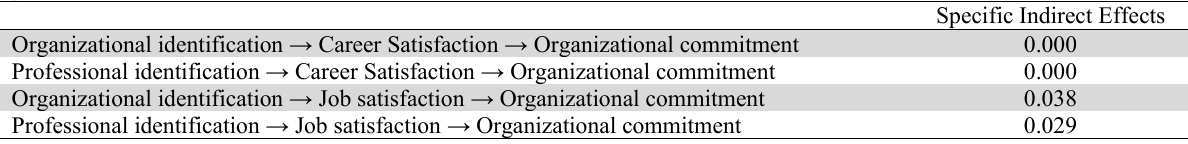
Specific Indirect